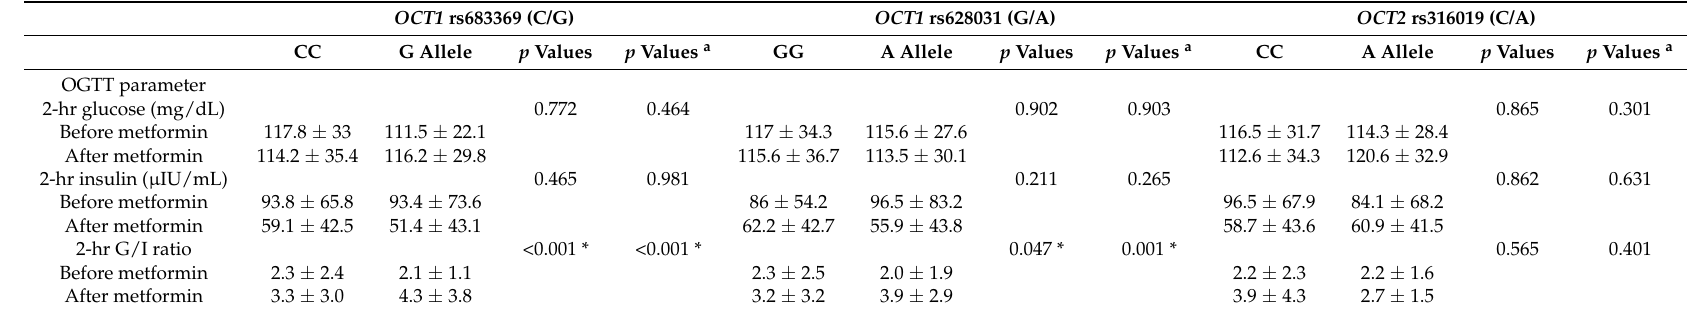
OGTT parameter 2-hr glucose